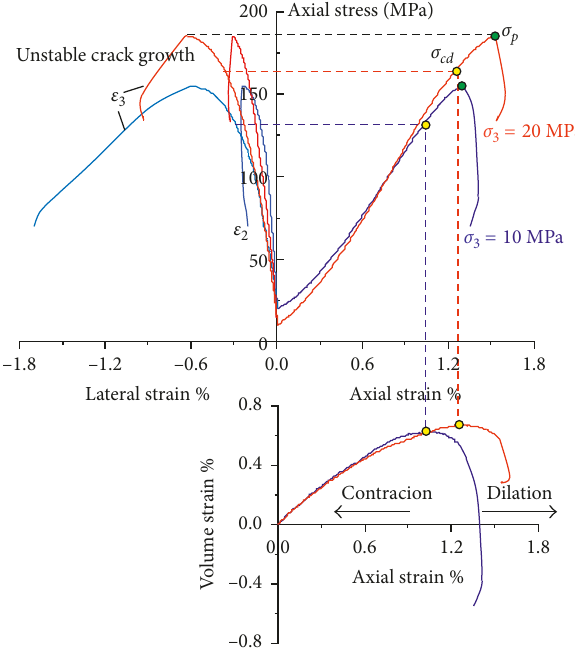
Figure 7: Stress-strain curve of rock at varying σ